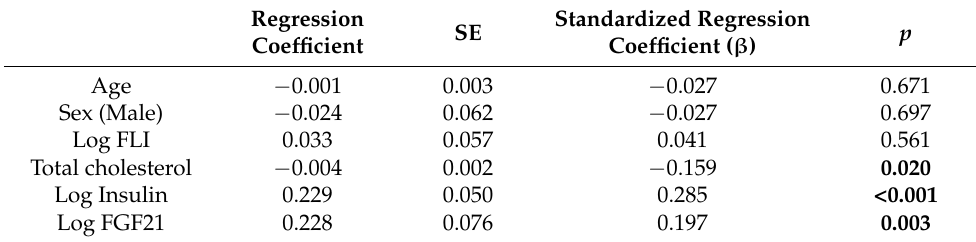
Table 3. Multivariable regression analysis for Log